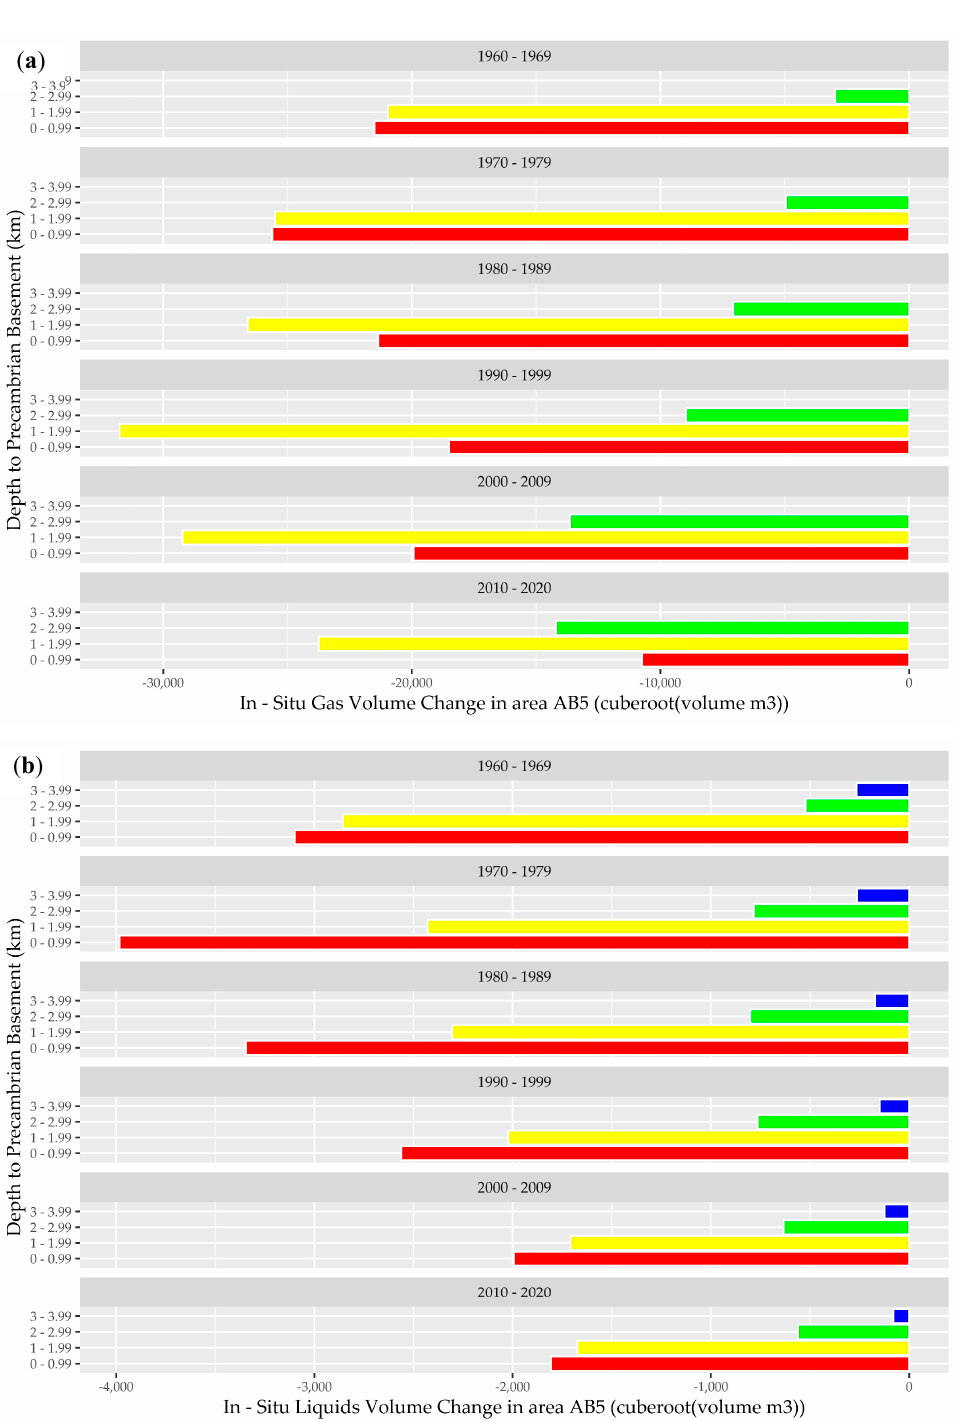
Figure 7. Calculated net in situ ( a ) gas and ( b ) liquid balance for AB5 over the period January 1960 – December 2020. Red bars: <1 km depth from Precambrian basement; Yellow bars: 1–2 km depth from Precambrian basement; Green bars: 2–3 km depth from Precambrian basement; Blue bars: 3–4 km frm Precambrian basement. Source data extracted from geoLOGIC Systems databases ©